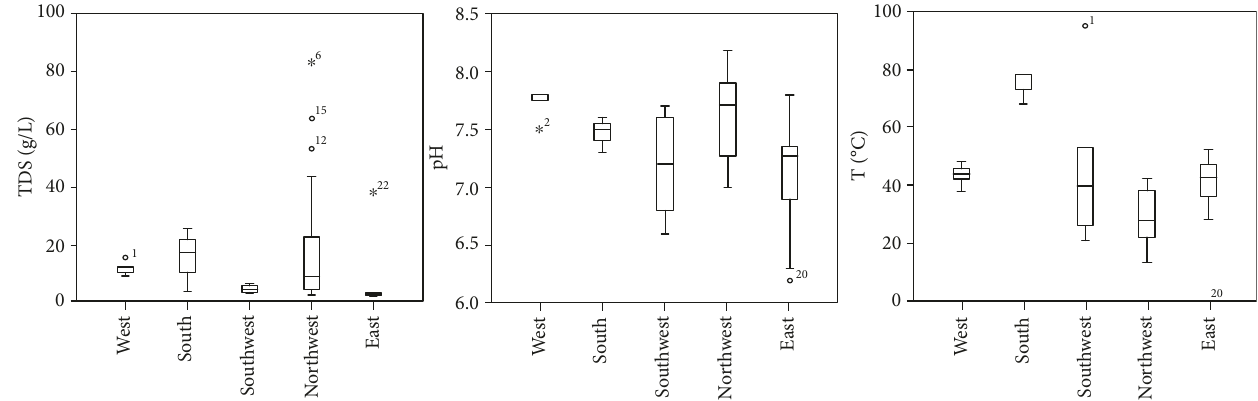
Figure 3: Plots of TDS, pH, and temperature (T) of water samples in di ff erent areas in the Sichuan Basin.